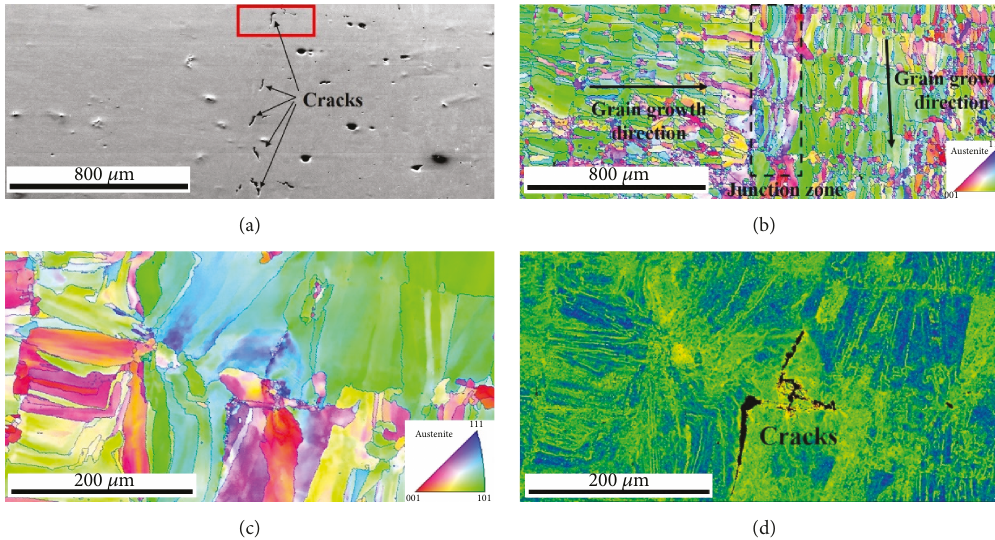
Figure 21: (a) SEM of the junction area in sample 2, (b) inverse pole fi gure of the junction area, (c) inverse pole fi gure of the enlarged area in (a), and (d) the kernel average misorientation map.